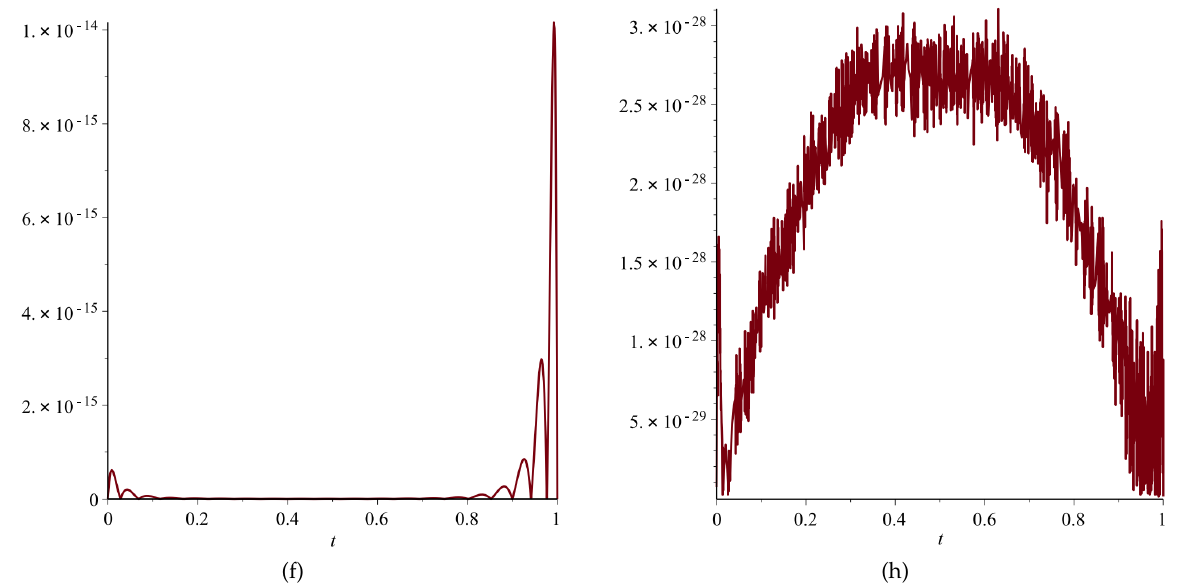
Fig. 3. The absolute errors | e N ( t ) | of the approximate solutions u ( t ) , for n = 20 (f) with a 0 = 20, b 0 = − 10 and n = 40 (h) with a 0 = − 15, b 0 = 20 of Example 2.